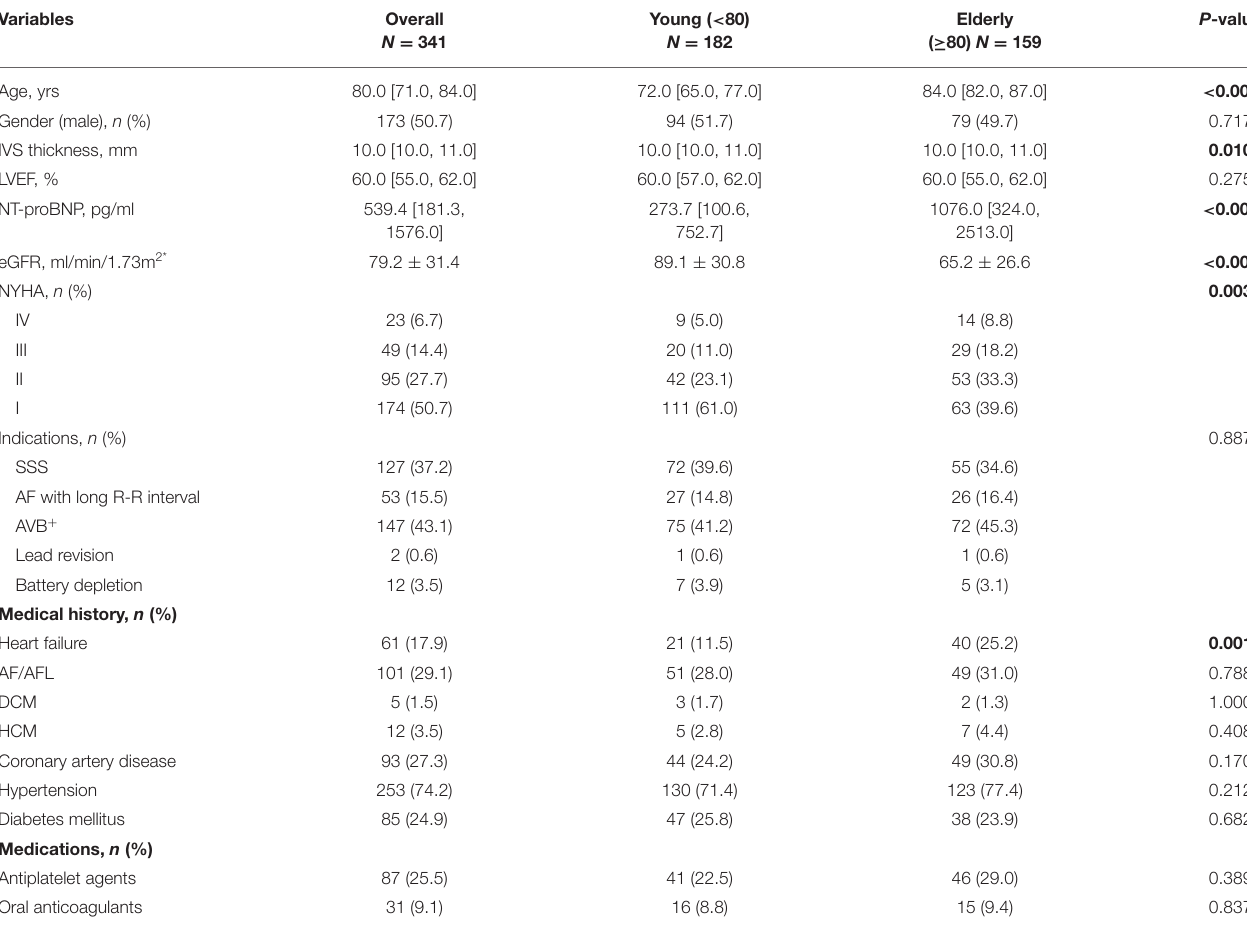
TABLE 1 | Baseline characteristics of both young and elderly patients. Variables